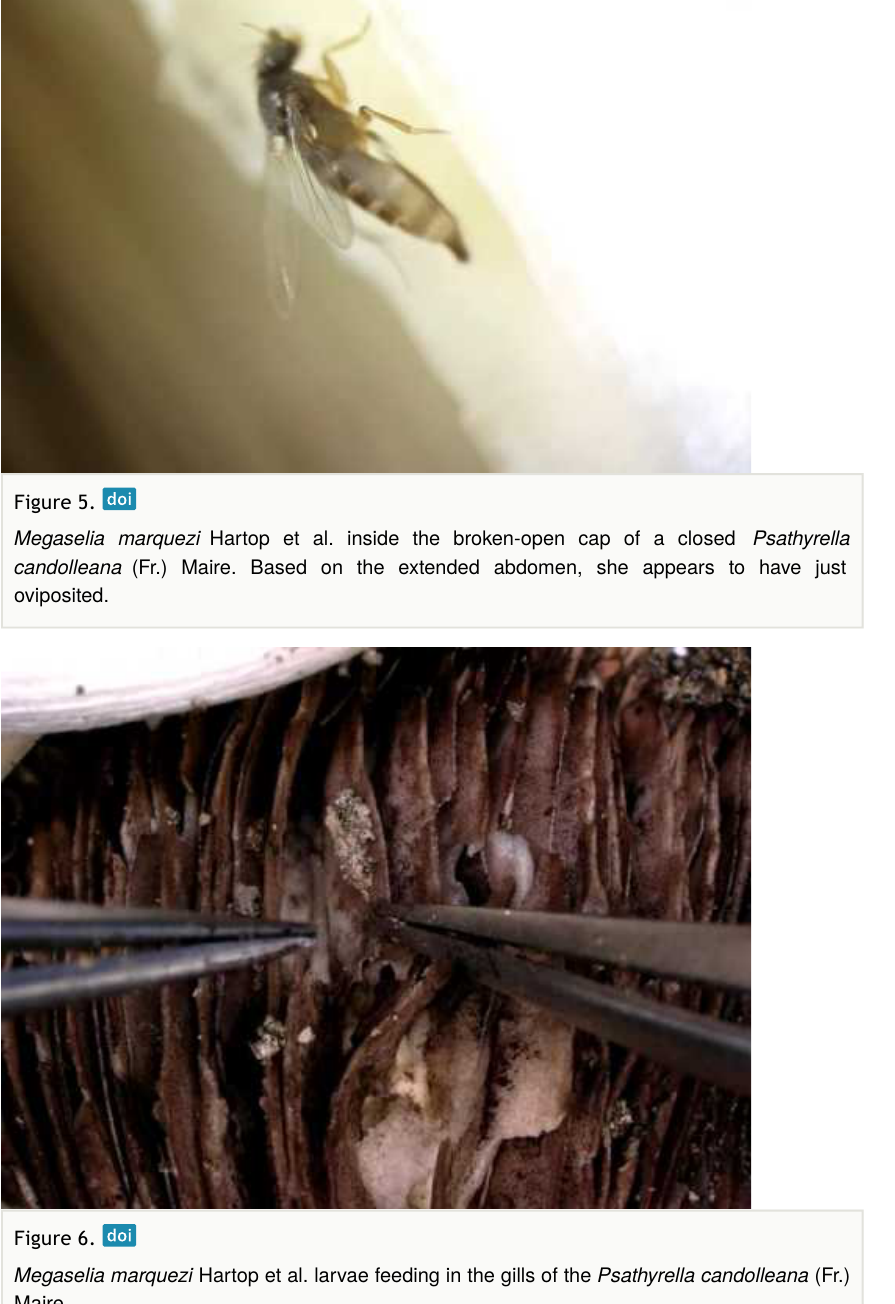
Figure 6. Megaselia marquezi Hartop et al. larvae feeding in the gills of the Psathyrella candolleana (Fr.)